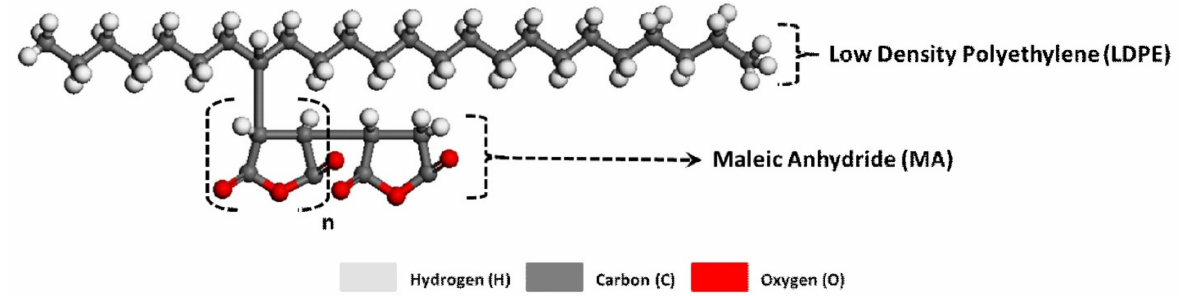
Figure 9. Molecular configuration of chemical reactions between the MA and LDPE in the case of LDPE-BFs MA composite sheet. Here, n represents the oligomerization degree of